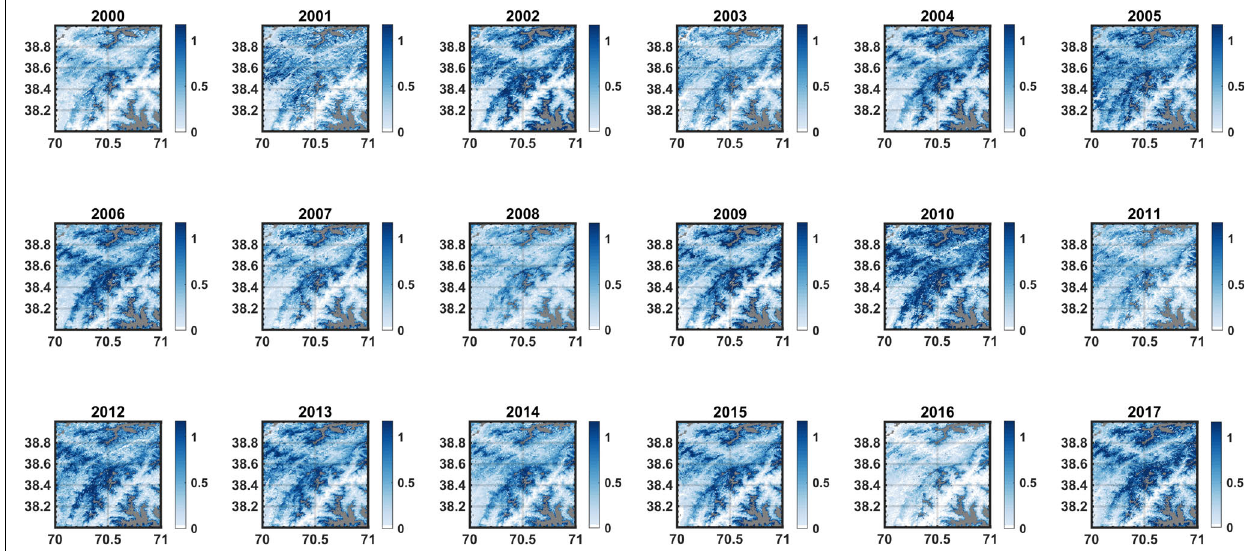
FIGURE 10 | Maps of annual (WYs 2000–2017) pixel-wise peak SWE (in meters) for tile (38 ◦ N , 75 ◦ E ). The gray pixels represent those masked out as pre-identified glaciers, likely glaciers (i.e., pixels with persistent carry-over SWE in more than 14 out of 18 years), or open water bodies. For reference, the DEM of this tile is shown in Figure 1